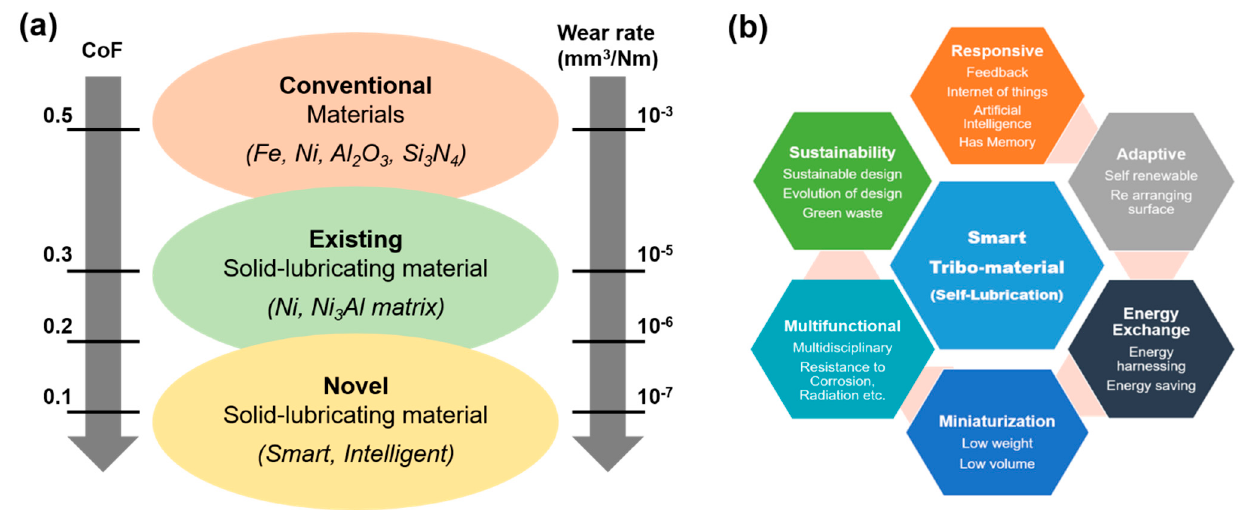
Figure 16. ( a ) Evolution of an HT solid ‐ lubricating material in terms of CoF and wear rate, and ( b ) features of a ‘smart’ solid ‐ lubricating material [3].